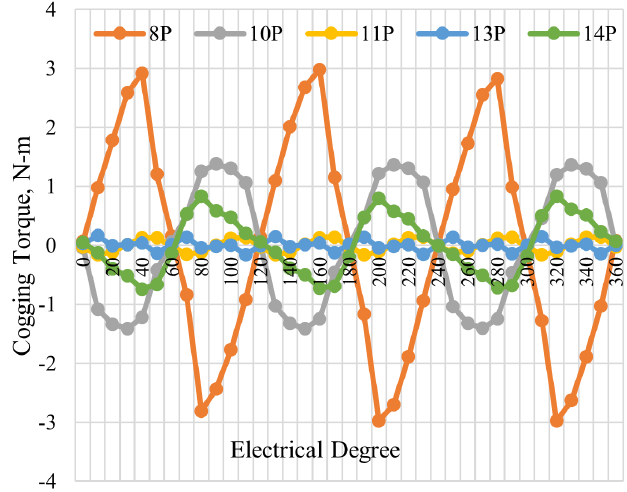
Figure 8. Cogging torque of different rotors.